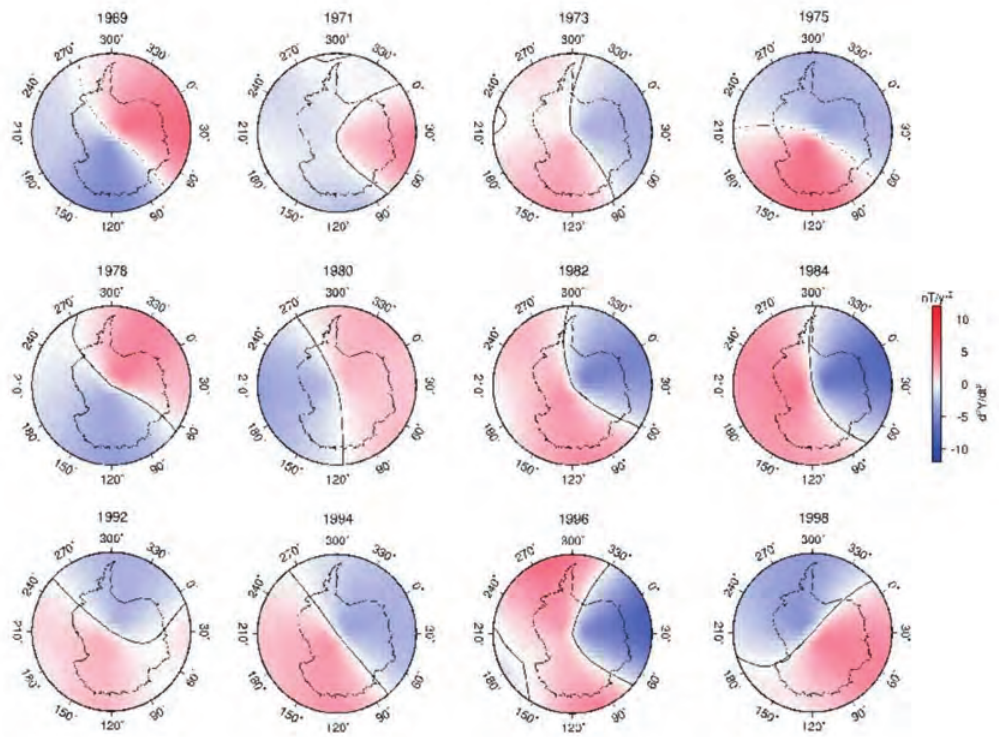
Fig. 2. Secular acceleration maps relative to the Y component over the Antarctic continent obtained using syn- thetic data given by the CM4 model. The solid line corresponds to the zero separating the zone characterized by negative (blue) and positive (red) values of secular